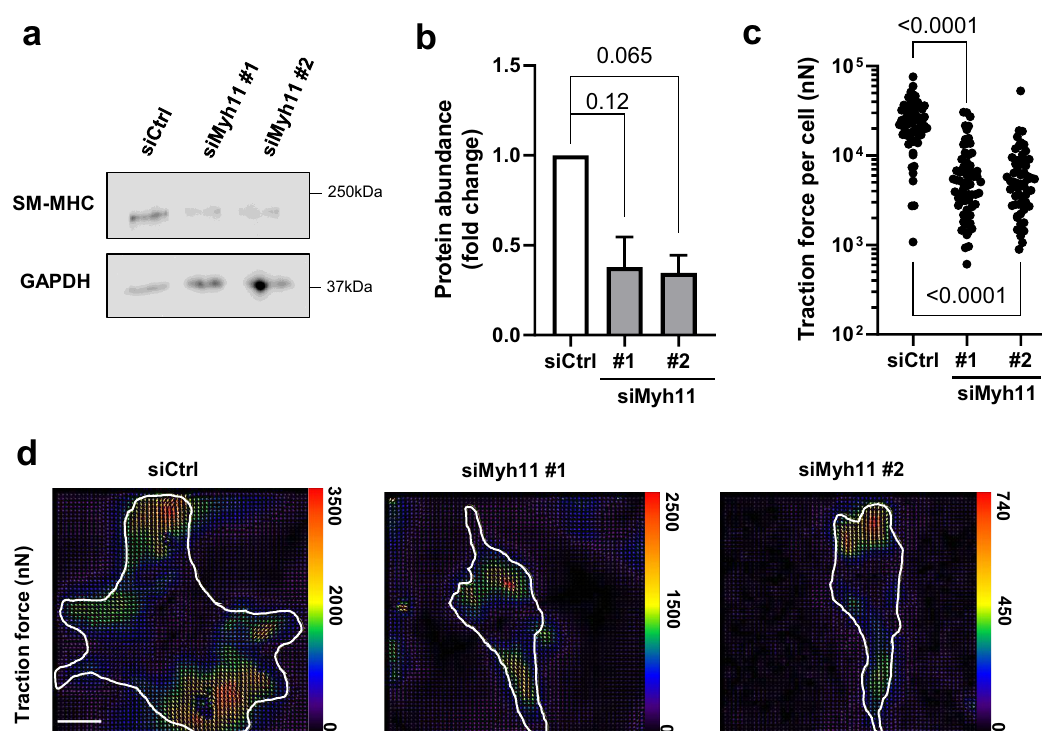
Figure 4. Knock down of SM-MHC reduces force generation in WT SMCs. Aortic SMCS isolated from 2-month WT mice were incubated with a control siRNA (siCtrl) or two distinct siRNAs targeting Myh11. ( a ) Representative images of lysates from the transfected cells immunoblotted for SM-MHC and GAPDH (loading control). Black boxes around the immunoblots indicate cropping for the removal of extraneous space. Unprocessed blots are shown in Fig. S1. ( b ) Quantification of immunoblotting results normalized for loading and plotted relative to the siCtrl control . Results show mean ± SE (n = 4–5). Significance was determined by Wilcoxon signed rank test. ( c ) Total traction force plots of siCtrl- or siMyh11-treated SMCs (n = 63–69 cells). Each dot represents the total traction force of a single cell. Significance was determined by Mann–Whitney tests. ( d ) Representative traction force images of cells analyzed in panel c. Cell areas are outlined in white, and traction force scale bars (in nanonewtons) is displayed to the right of each respective image. Optical scale bar = 50